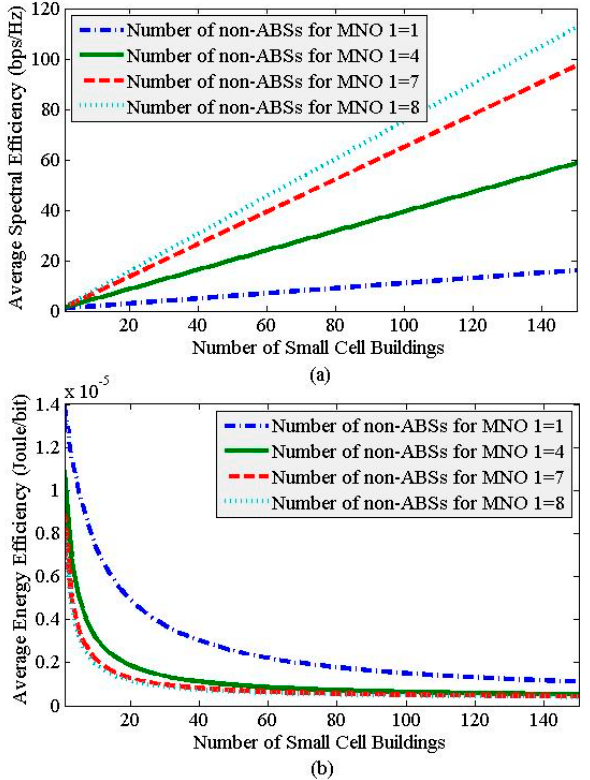
Figure 7. System-level spectral e ffi ciency ( a ) and energy e ffi ciency ( b ) performances of MNO 1 with the density of small cells, i.e., for L ≥ 1.